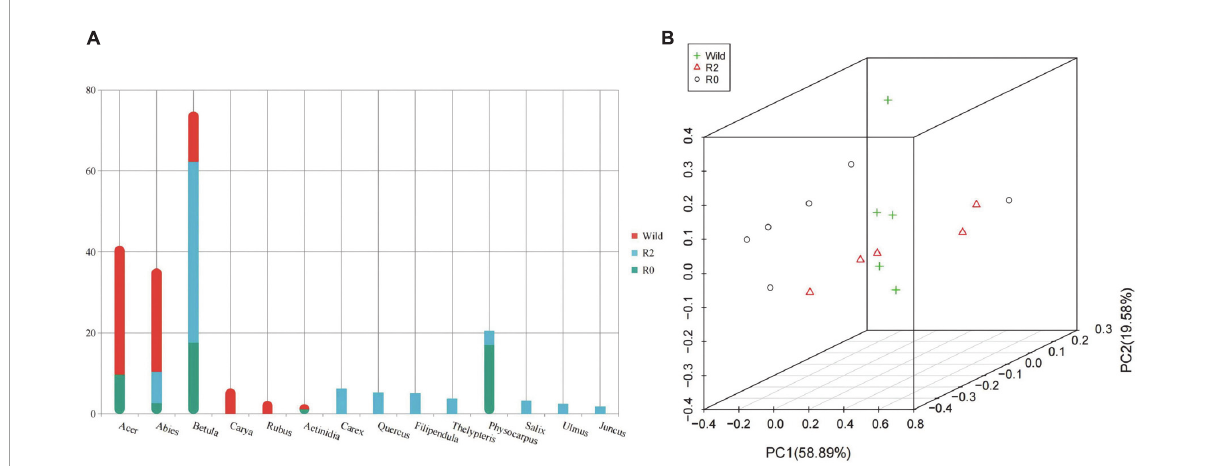
FIGURE2 The feeding composition and structure of Wild, R2, and R0 groups. (A) A stacked bar graph based on the abundance of different plant genera. (B) The 3D PCoA plot of feeding composition based on Bray-Curtis distance metrics.